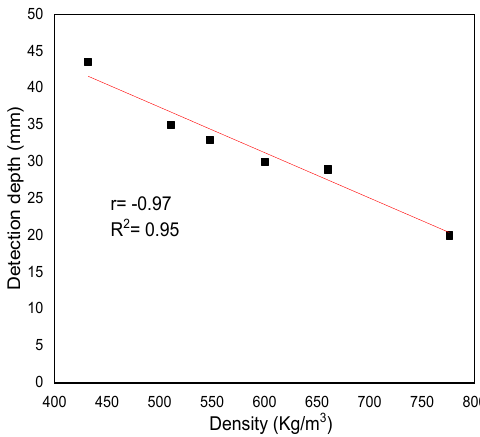
Fig 3 . Relationship between maximum detection depth and density of different wood species.